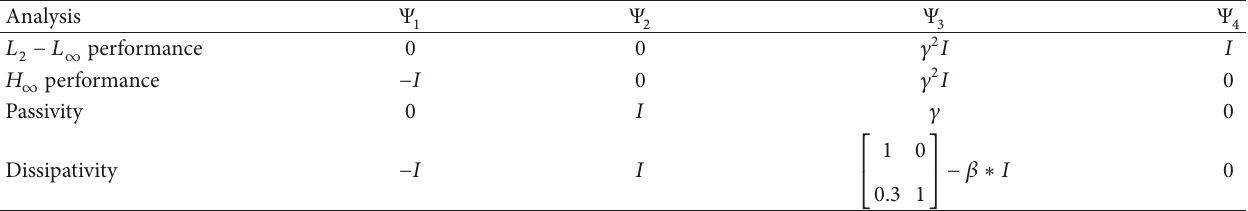
Table 1: Matrices for each case.